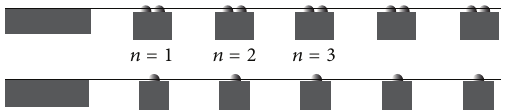
Figure 5: Scheme of track in transition zone with two types of sleepers and fastening systems.